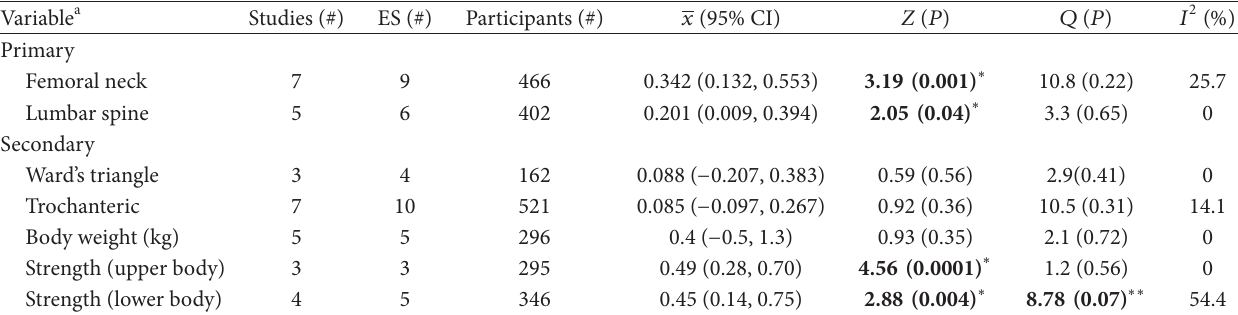
con�dence intervals. e middle of the black diamond represents ) while the le and right extremes of the diamond represent the corresponding 95 . Negative results favor control groups while positive results favor exercise % 𝑔𝑔 𝑔𝑔 T 3: Changes in primary and secondary outcomes.